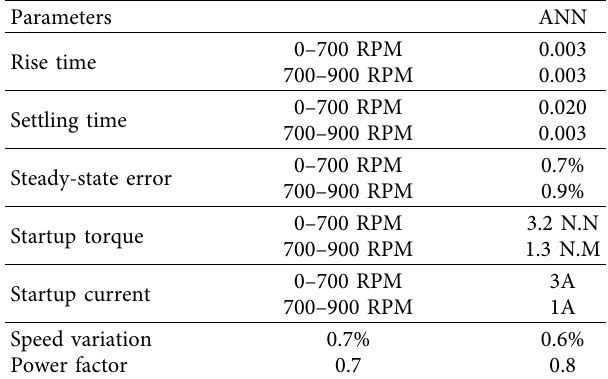
E of the BLDC motor.